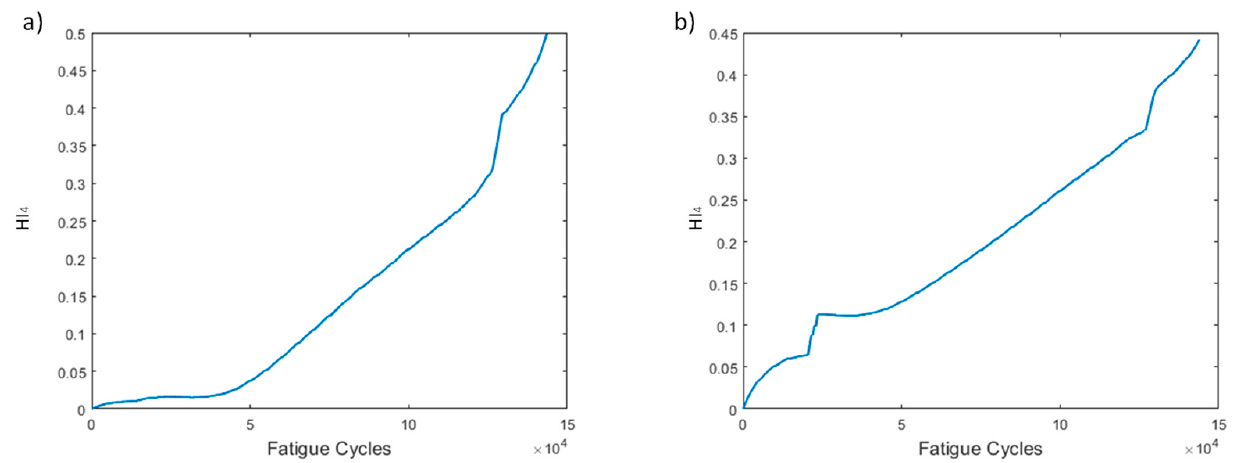
Figure 8. HI 4 progression through time for the two pre-processing methods for specimen CA-2: ( a ) method 1, ( b ) method 2.